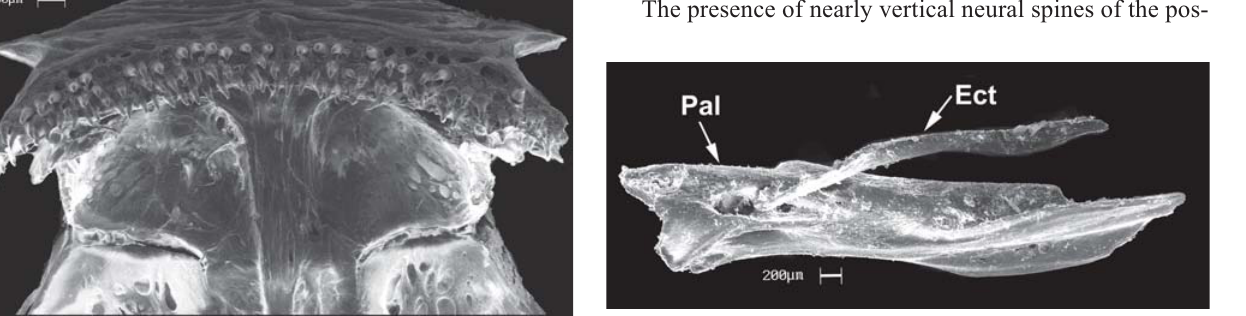
Fig. 5. SEM photograph of palatine and ectopterygoid bones, anterior toward top of page, in Propimelodus araguayae , INPA 26121, paratype. pal, palatine; ect,